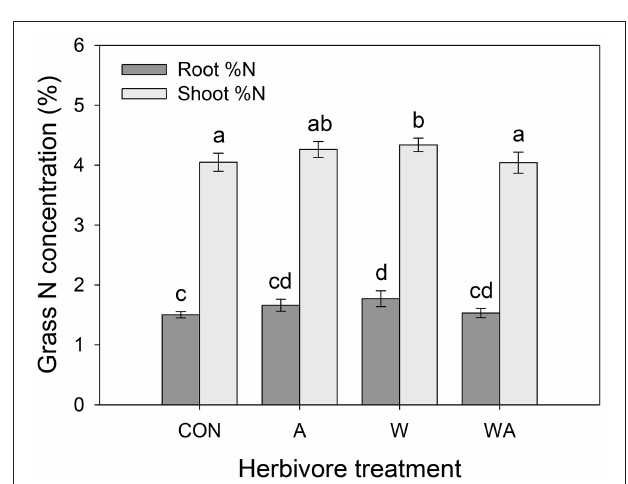
with weevils alone compared with control plants ( Figure 6D ).